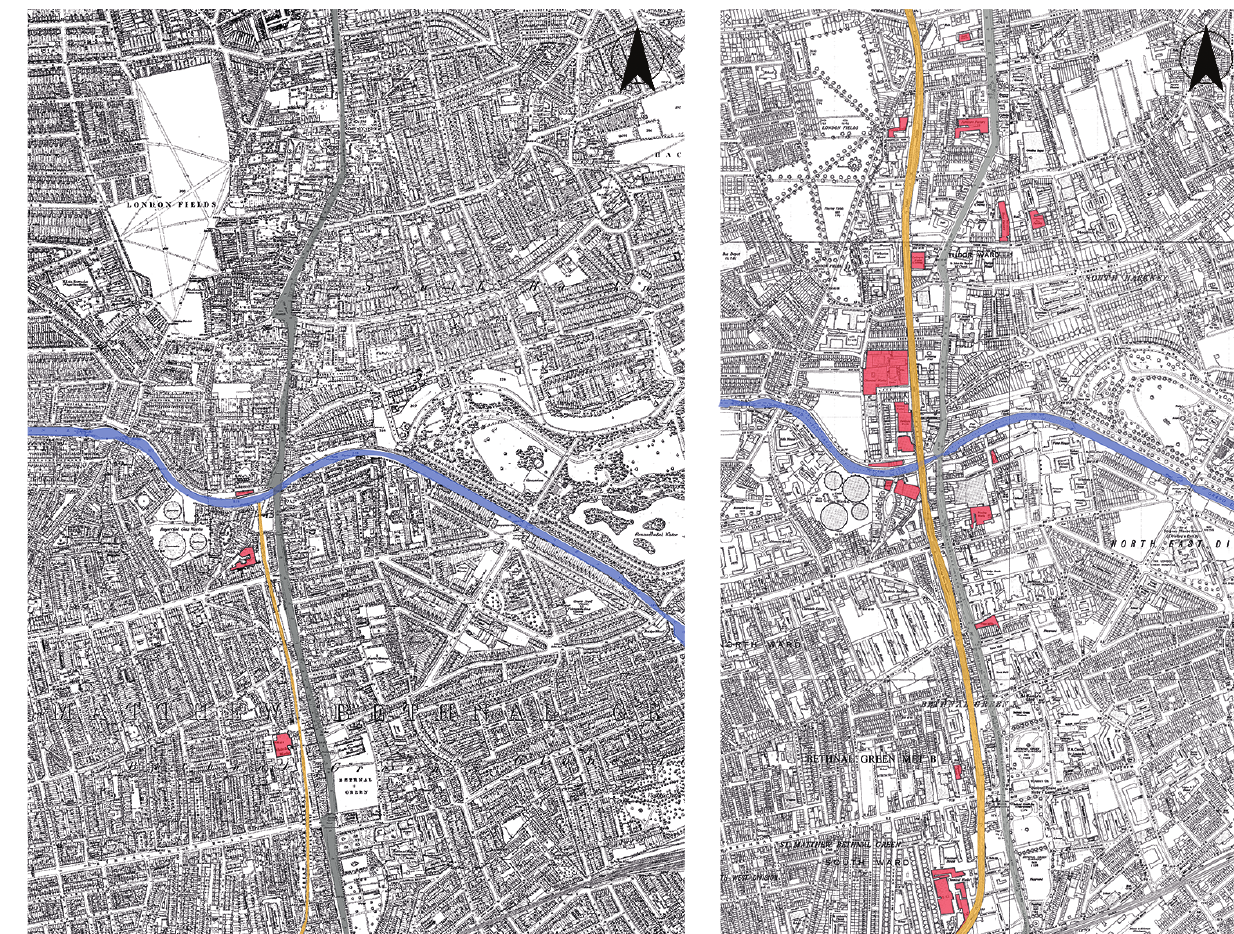
Figure 2. Historical maps of Hackney Mare Street: 1880 (left) and 1951 (right). Highlighted in blue is the Regent’s Canal; in orange, the railway; in grey, Mare Street; and in red, manufactories, industrial buildings, and workshops. Source: Ordnance Survey (2019). Created 12 July